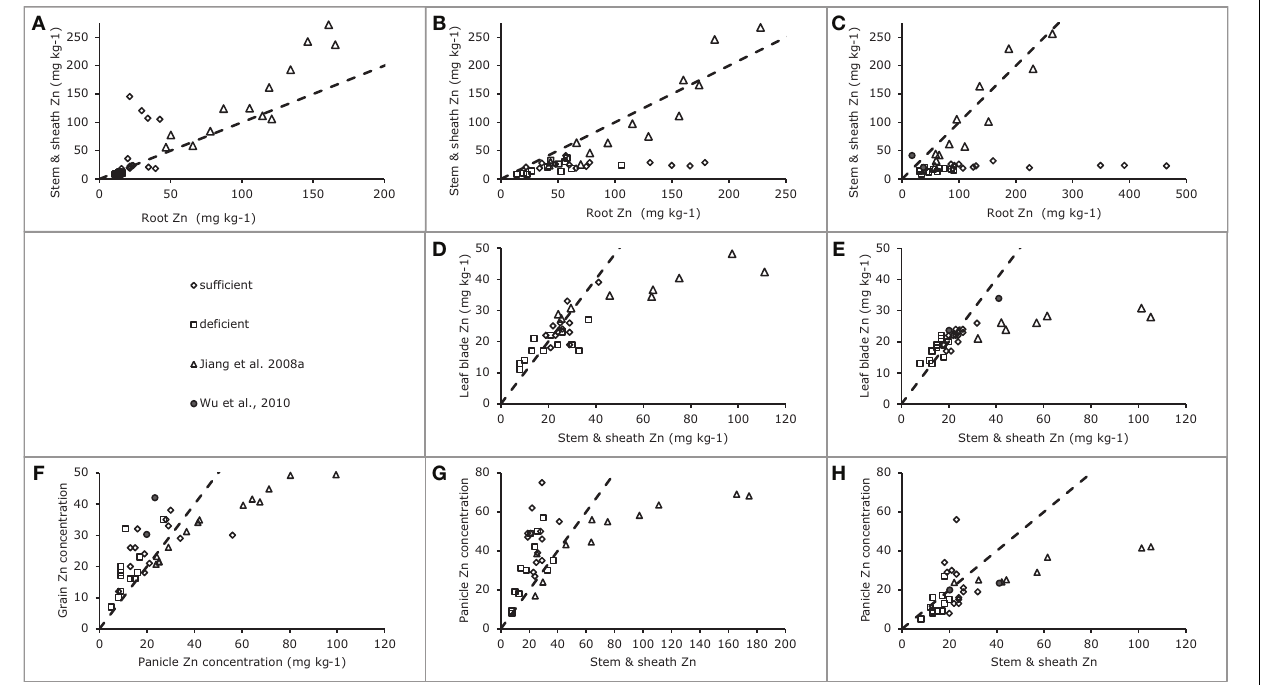
tested genotype grown at either sufficient (diamonds) of deficient (squares) Zn nutrition, data points from Wu et al. (2010) (filled circles) represent averages of two genotypes grown at sufficient Zn nutrition and data points from Jiang et al. (2008a). (Experiment 4) (triangles) represent averages for two genotypes grown at a range of Zn nutrition levels. The broken lines indicate the 1:1 line in each